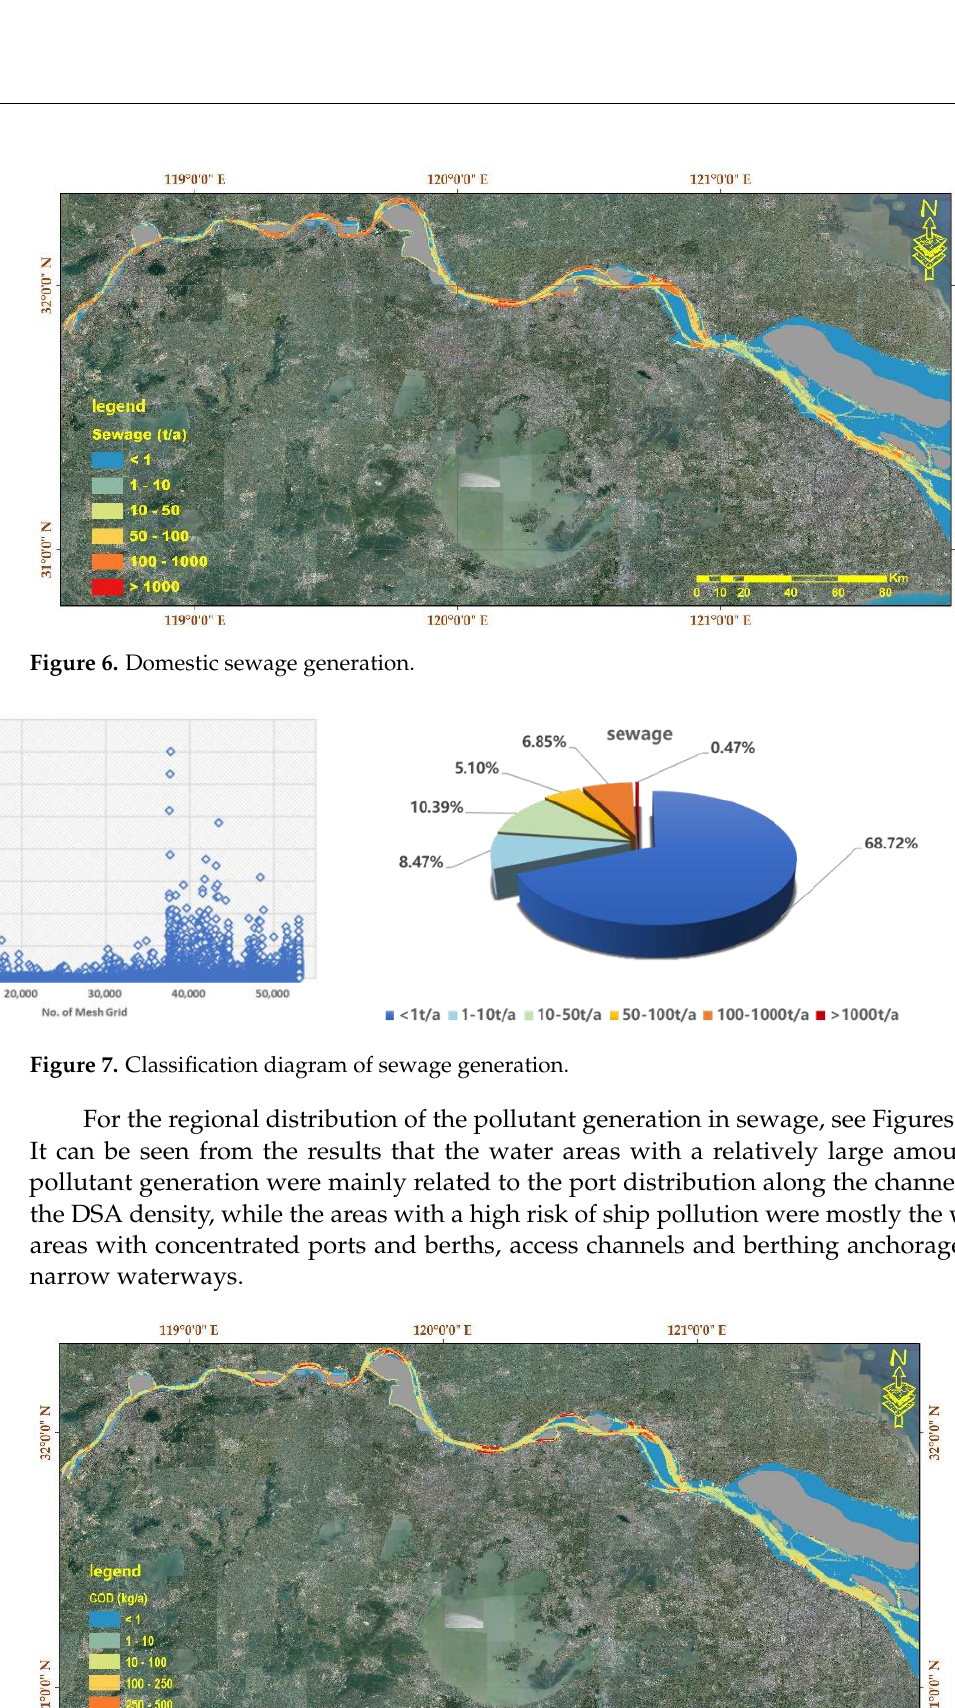
Figure 9. BOD generation distribution.